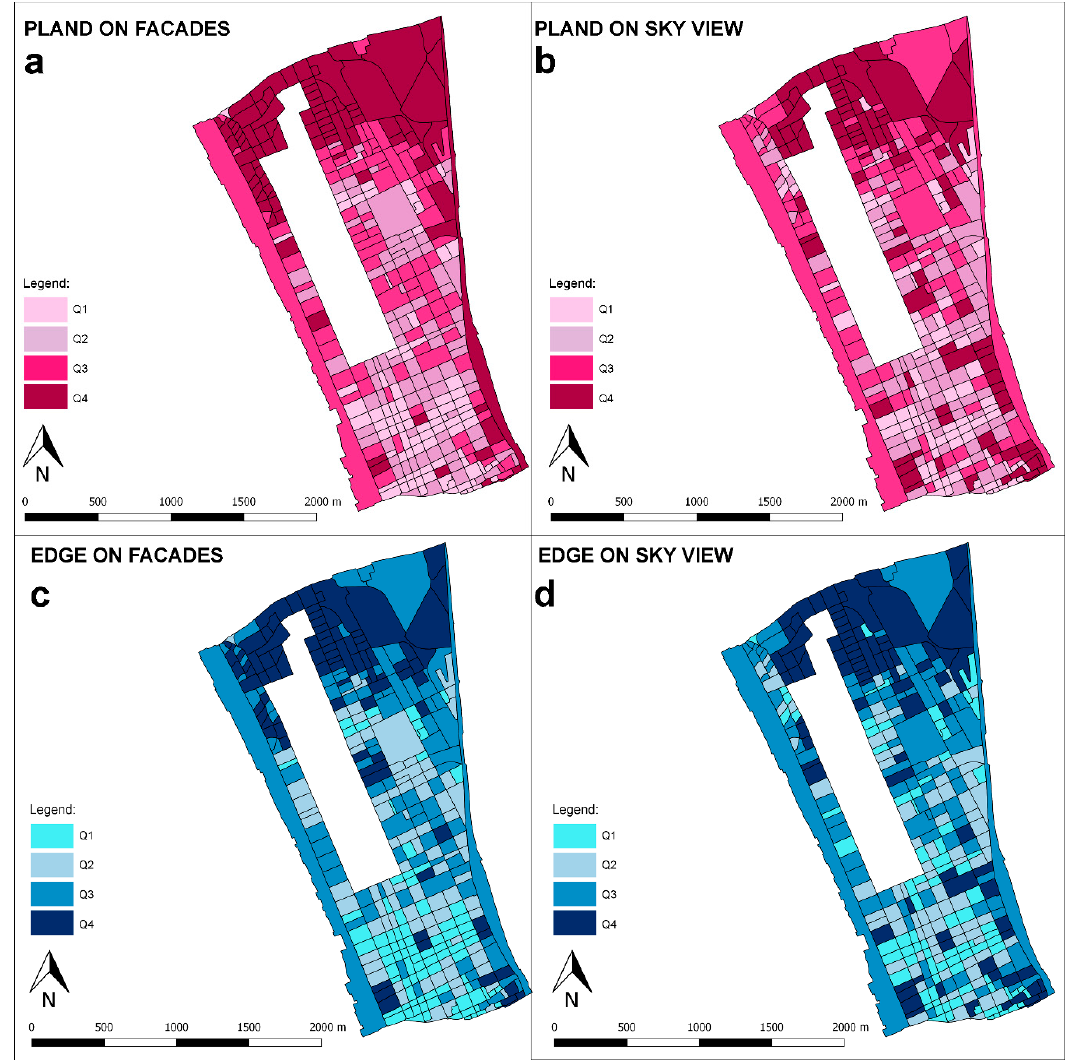
Figure 9. Maps of remote sensing metrics: ( a ) percent of landscape on facades; ( b ) percent of landscape on Sky; ( c ) edge density on facades; ( d ) edge density on Sky.